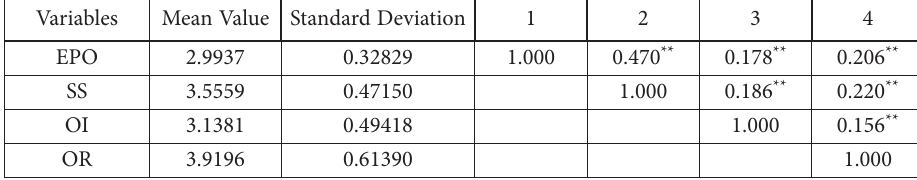
Table 3. Descriptive statistics and correlation coefficient of main variables (source: authors’ experiment) Variables